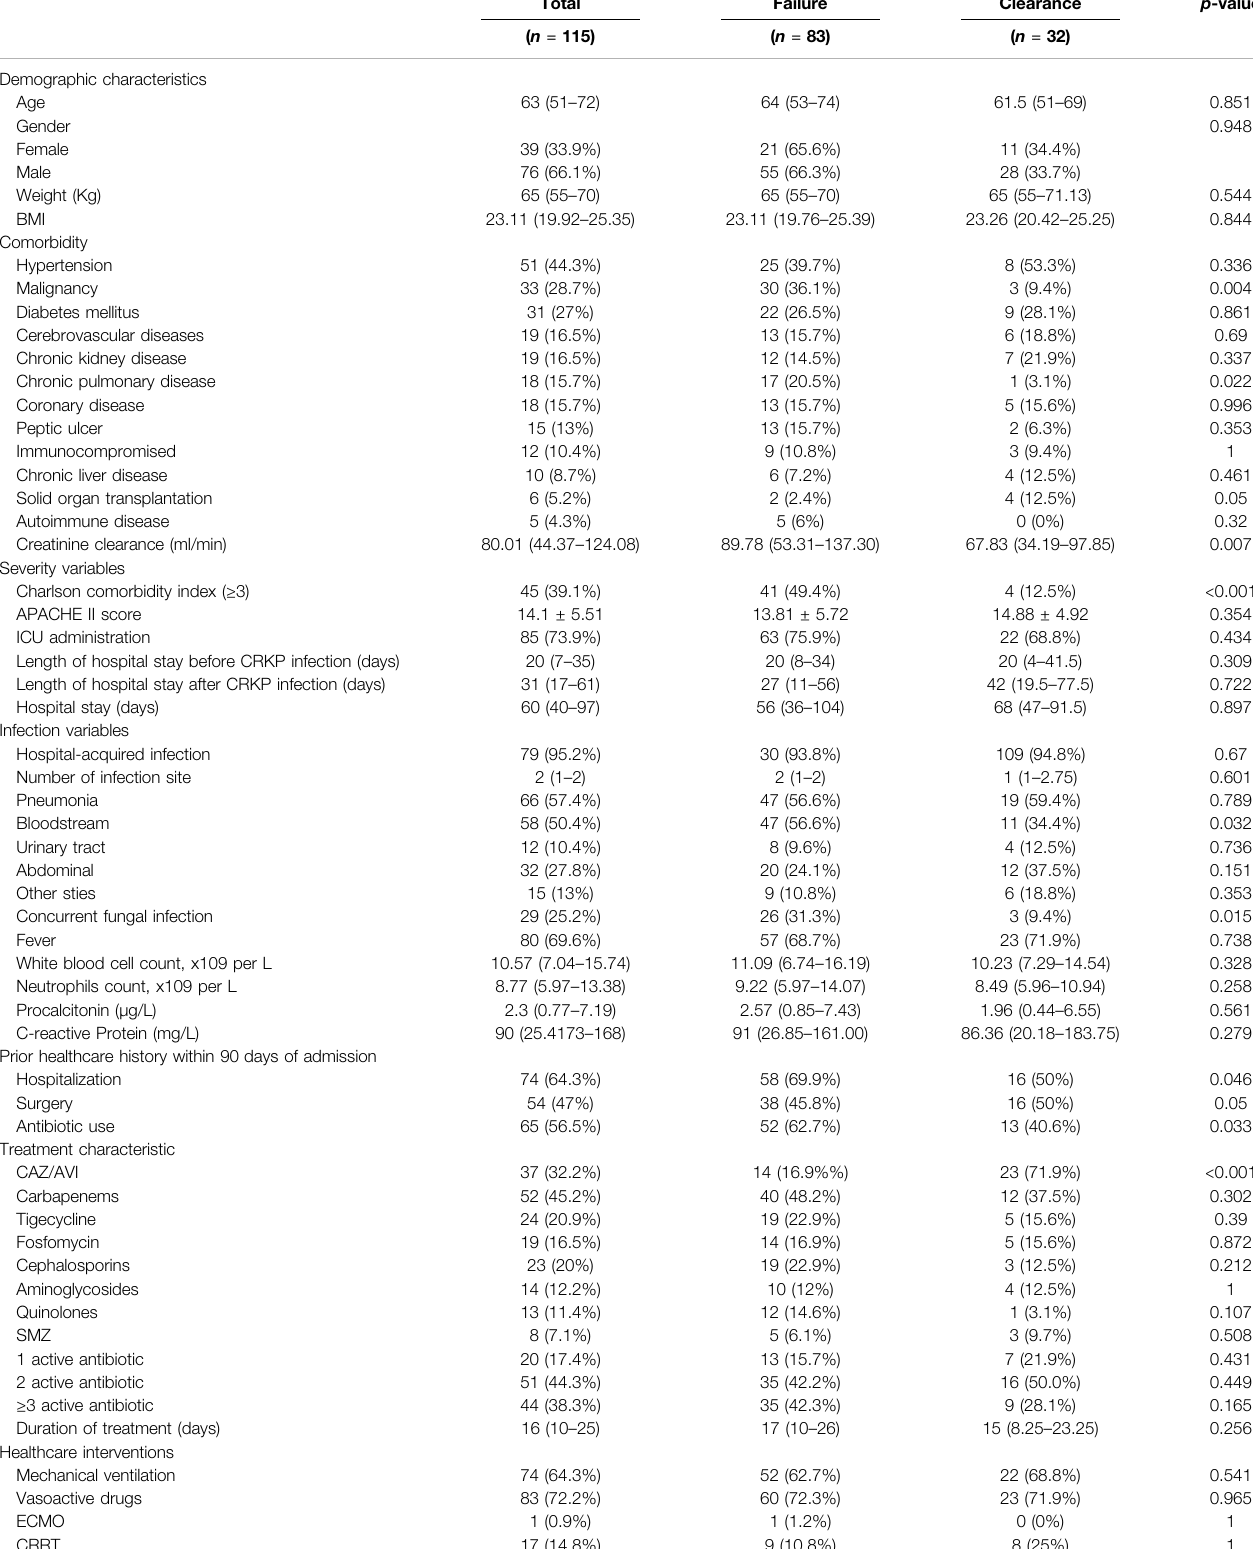
TABLE 3 | Univariate analysis of factors associated with 7-Day microbiological clearance in the 115 patients with CRKP